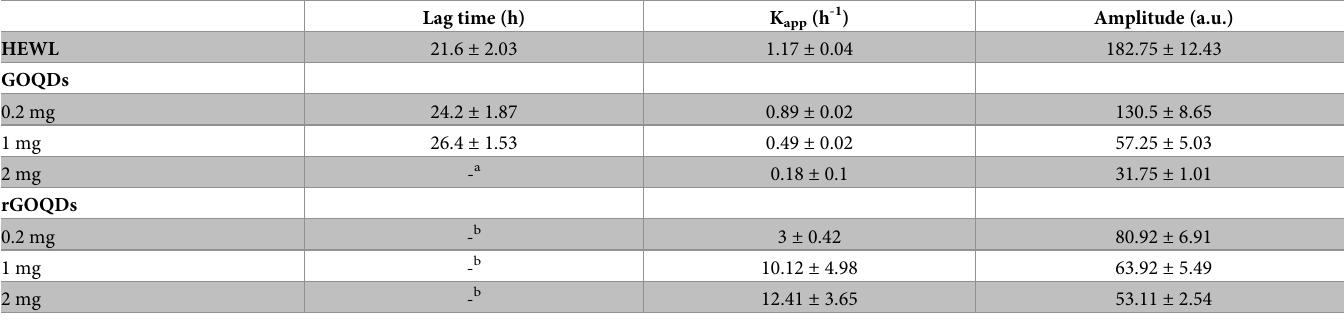
Table 2. Effect of GOQDs/rGOQDs on the kinetics parameters of HEWL fibrillization determined by ThT fluorescence assay.